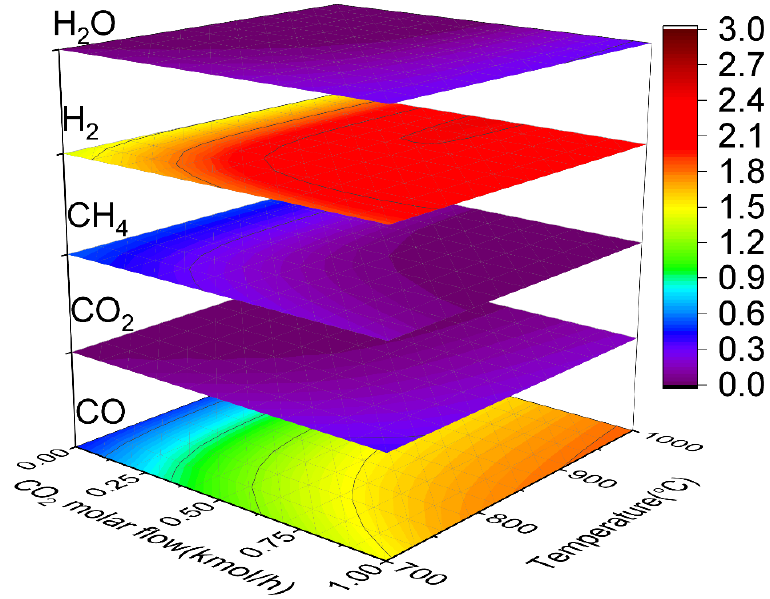
Figure 3. Effects of CO 2 flowrate and temperature on gaseous products.